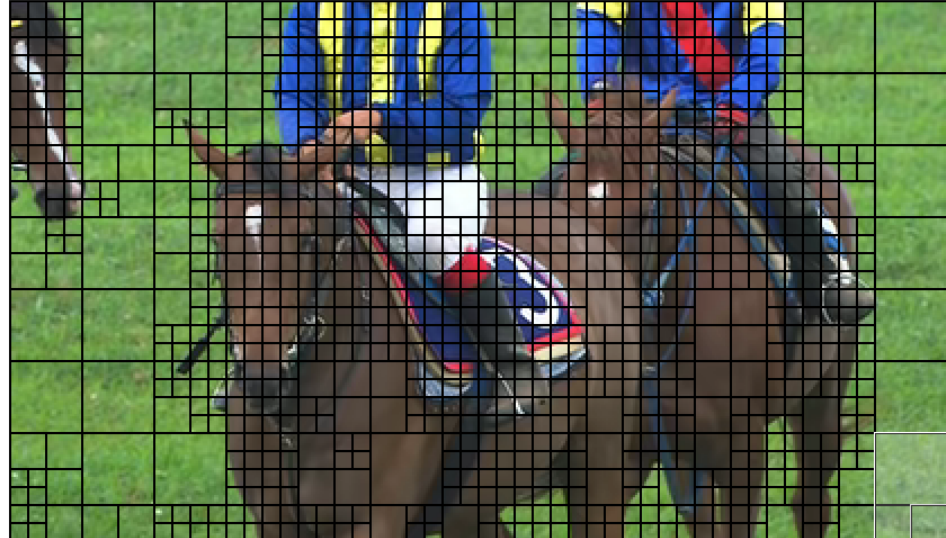
Figure 12. Partition results of the 180th frame in the sequence RaceHorses (416 × 240), which is encoded by the original HM 16.7 with QP 22. The black line represents the splitting boundaries between CUs.